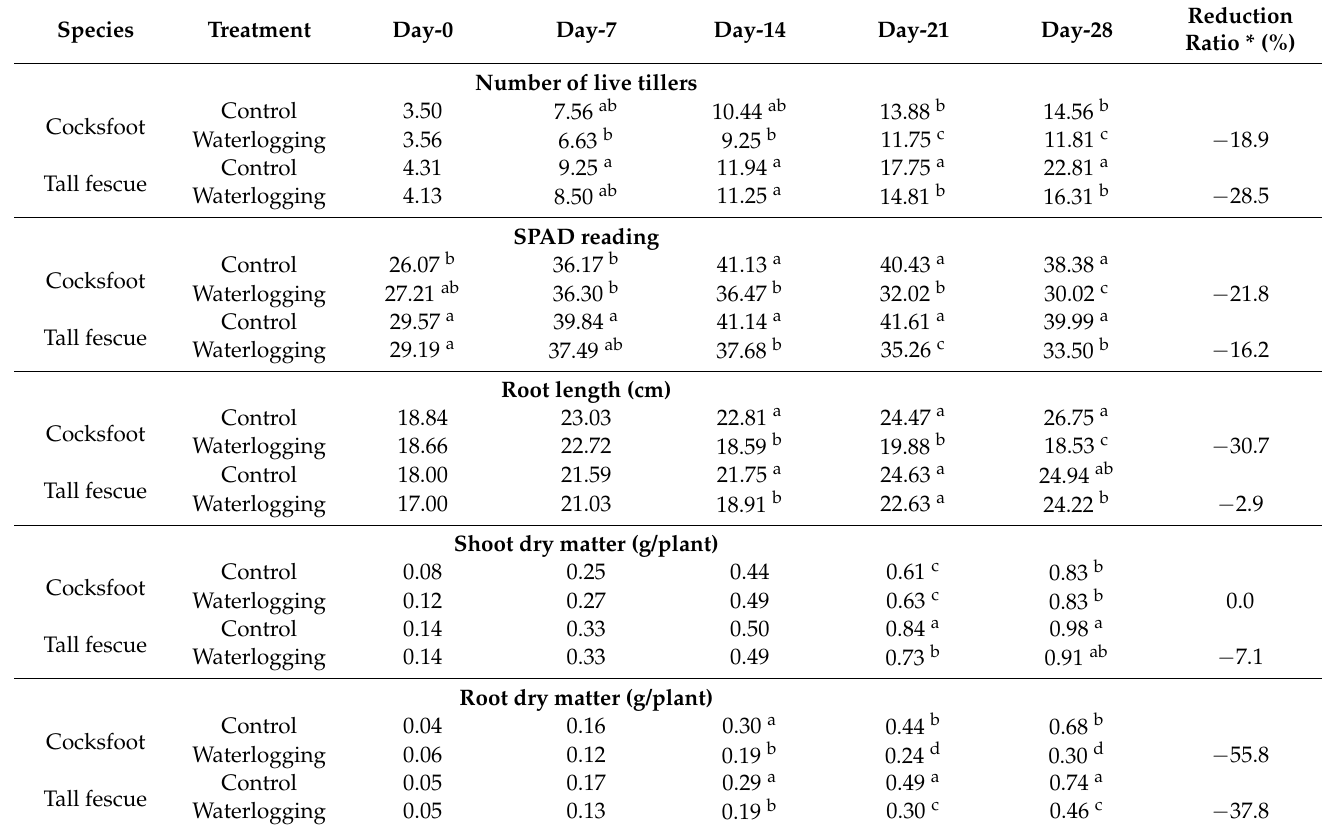
Table 2. Morphometric, biomass and chlorophyll measurements of tall fescue and cocksfoot in response to waterlogging. Values presented are least squares means of 4 replicates.